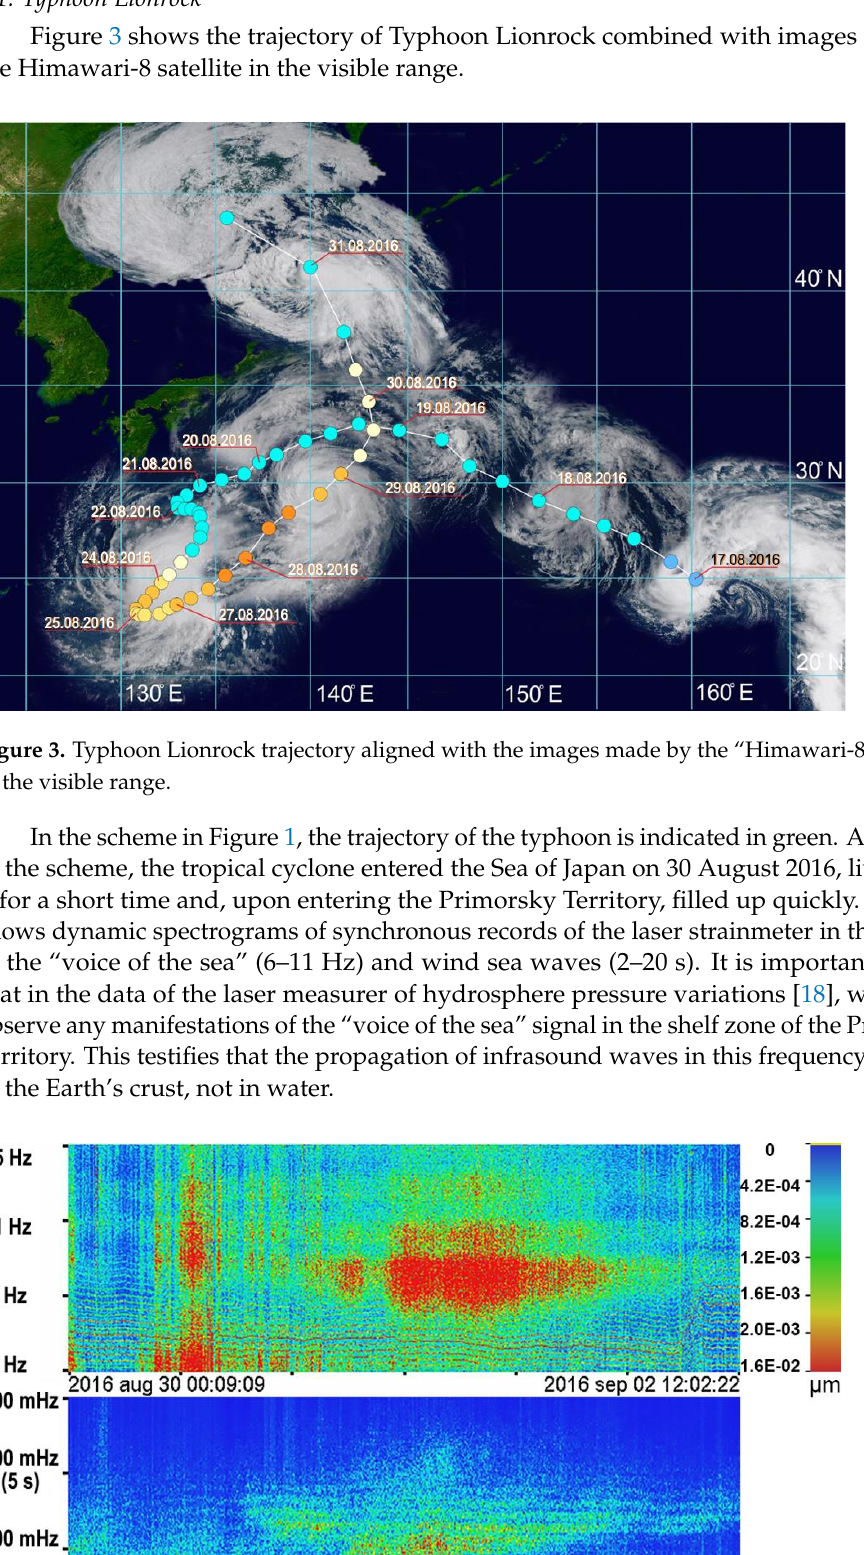
Figure 2. Suomi NPP images of studied tropical cyclones.